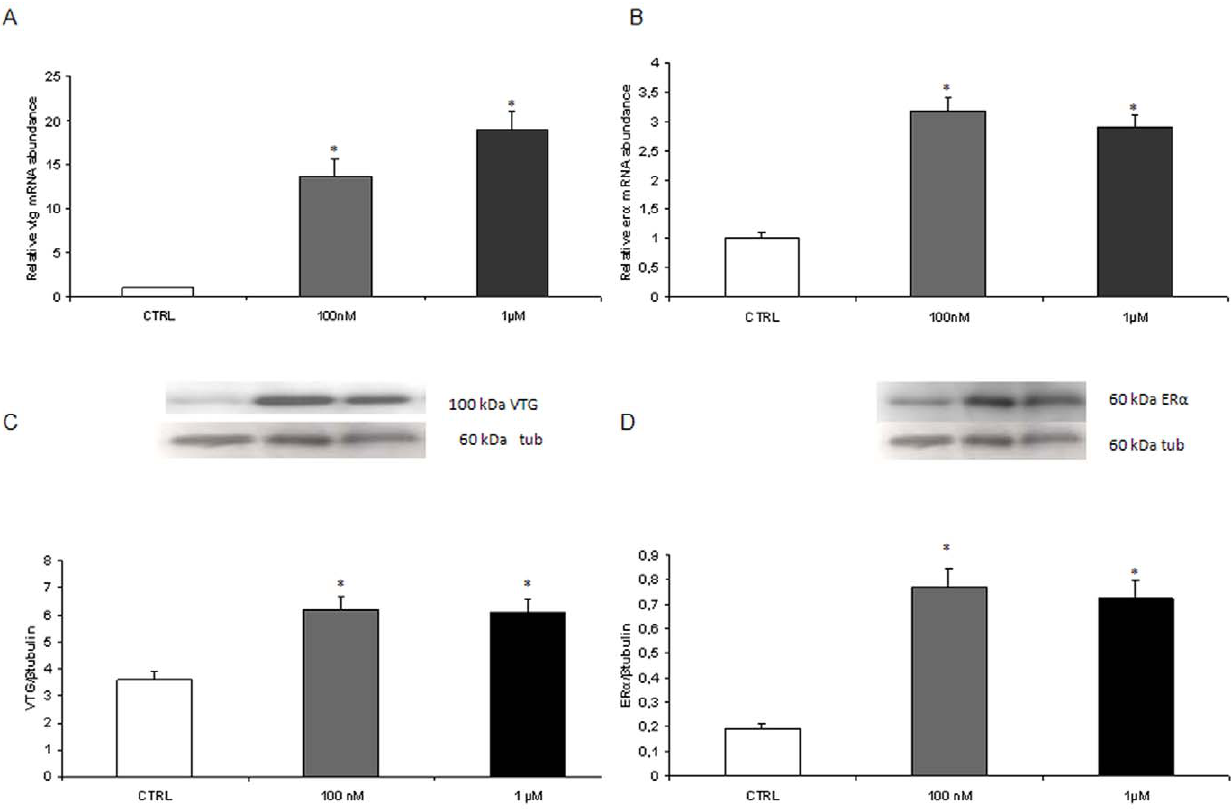
Figure 3. Effects of melatonin on follicles growth. (A) vtg and (B) er a mRNA levels, normalized against b -actin gene (C) VTG and (D) ER a typical Western blot normalized against b -TUBULIN and relative densitometric analysis, in liver of fish exposed to 100 nM and 1 m M MEL and control ones. n=15 per group. Error bars indicate the mean 6 SD. Asterisks denote exposure groups that are significantly different from the relative control group (p , 0.05), analyzed using ANOVA followed by Bonferroni’s multiple comparison test.